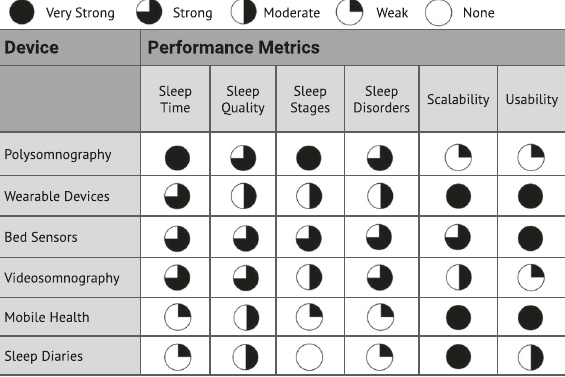
Fig. 4 Holistic evaluation of sleep-monitoring methods. Some methods, such as PSG, are accurate but inappropriate for use in daily sleep monitoring, as they require professional set up and are intrusive. Other methods, such as bed sensors, are unobtrusive but more prone to noise than